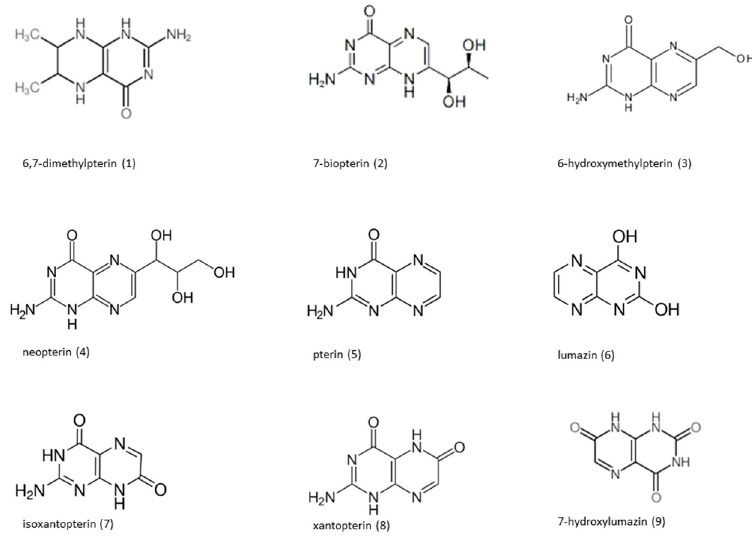
Figure 1. Chemical structures of the selected pterins.